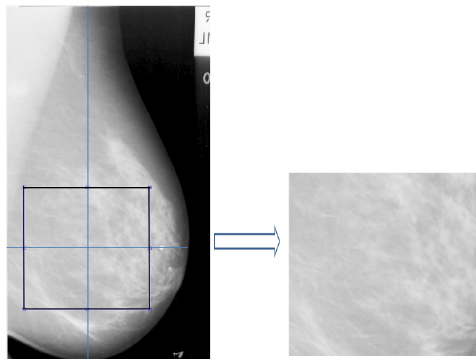
Figure 2. ROI extraction from the fibro-glandular disk